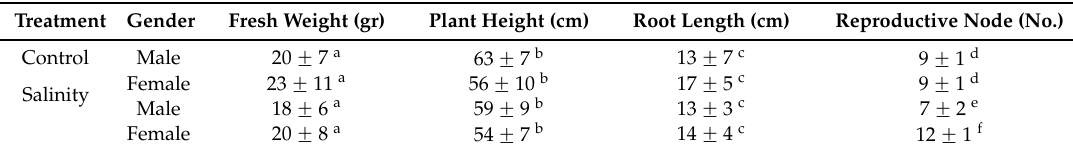
Table 2. Morphological parameters of female and male M. annua plants under salinity